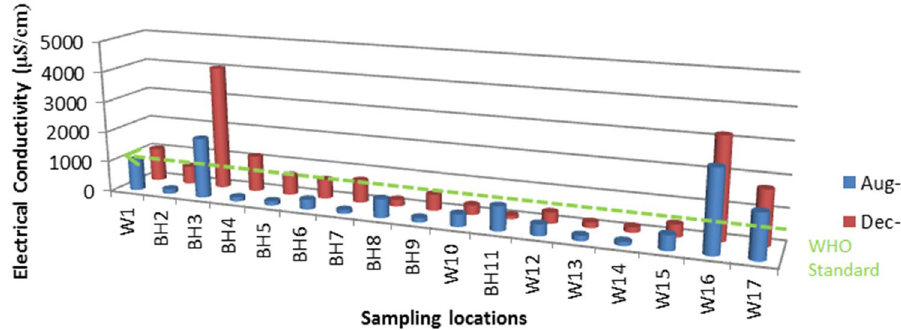
Fig. 9 Seasonal variations in EC concentration of water samples versus WHO standard around the Olusosun